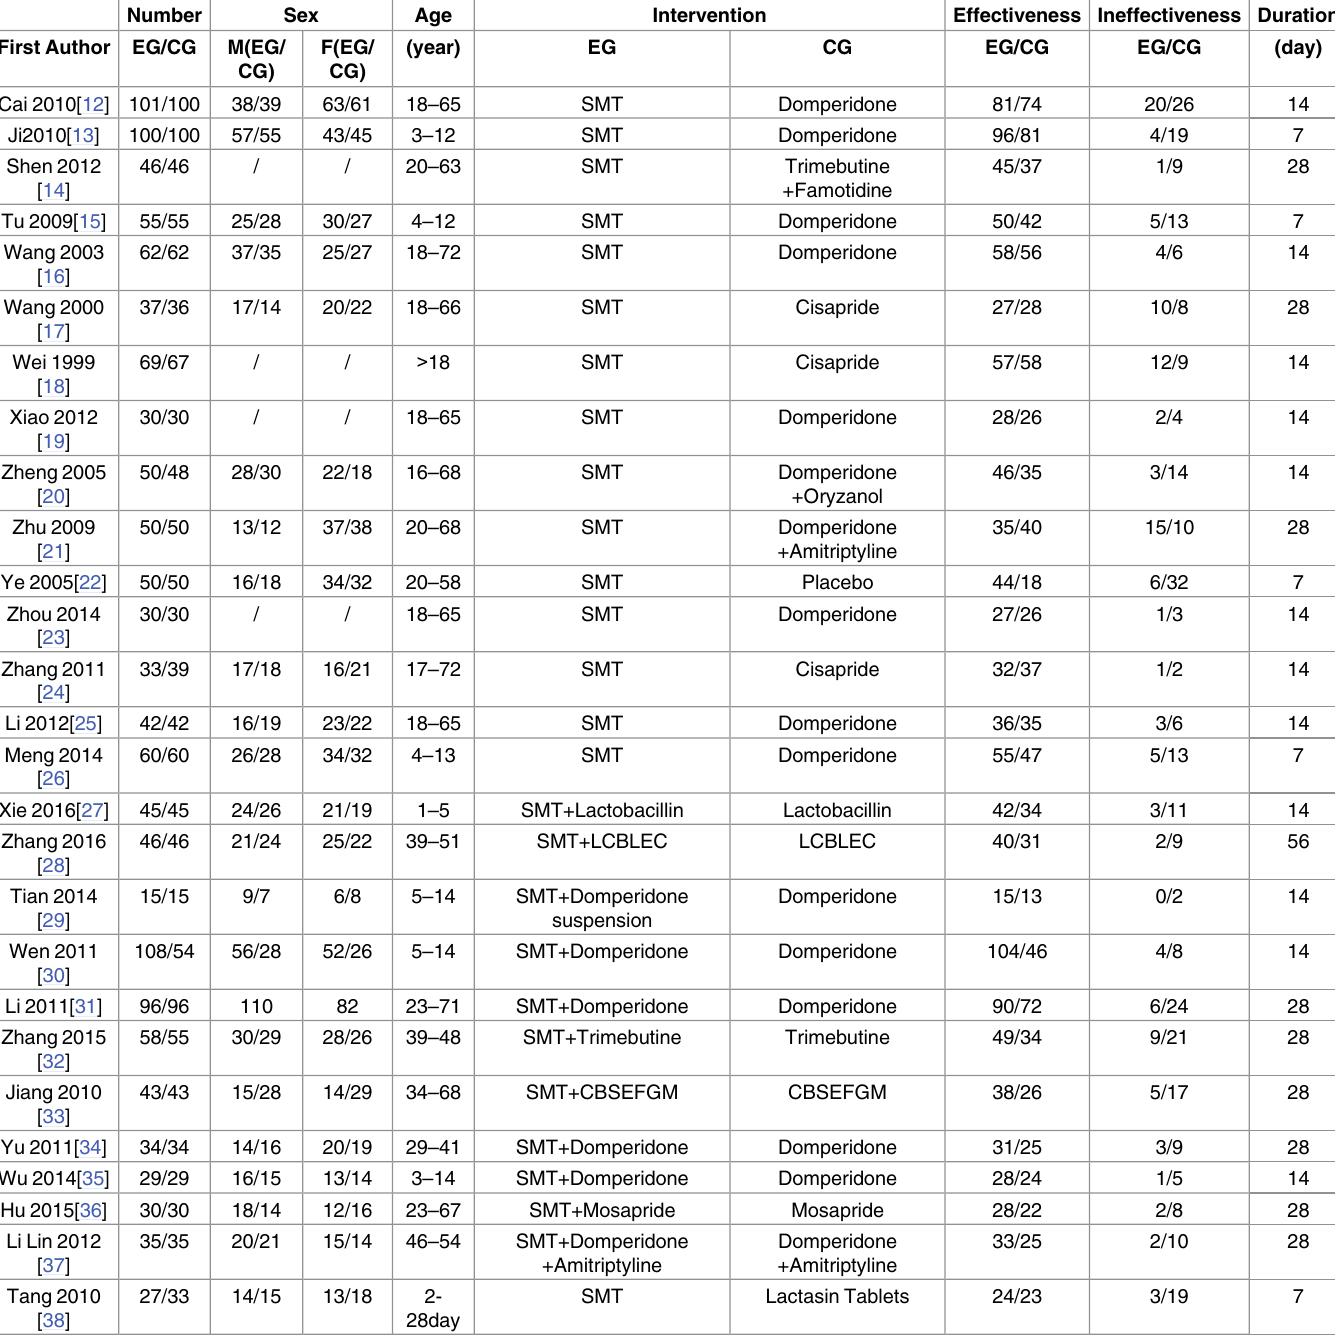
Table 1. Summaryof the characteristics of the included